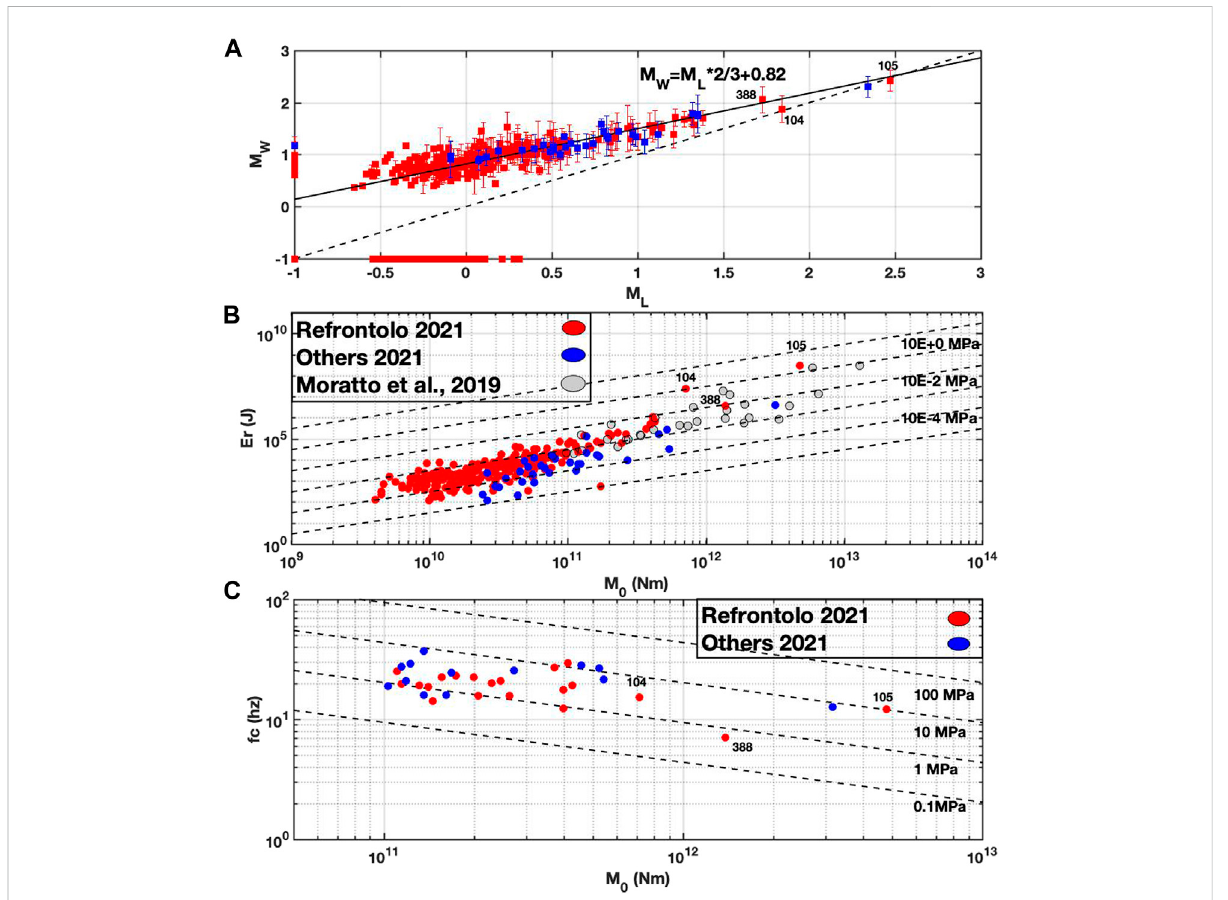
FIGURE 4 Comparison between source parameters estimated by the RSC network (HEL catalog): (A) M L vs. M W for the August 2021 events, Refrontolo sequence with red squares, the earthquakes in other areas in blue squares; the solid black line shows the empirical relationships of Lanzoni et al. (2020). Symbols along the axes (M-1) represent earthquakes without magnitude estimates (M W and M L on the x and y axes, respectively). (B) M 0 vs. radiated seismic energy (Er); symbol colors as in (A) , the gray circles represent previous events recorded by the RSC network and analyzed in Moratto et al. (2019). (C) M 0 vs. corner frequency (fc); dashed black lines represent the constant Madariaga stress drop. Event IDs of the three main earthquakes of the Refrontolo sequence as follows. 104: largest foreshock on August 3, 19:04:06, M L 1.8; M W 1.9; 105: main earthquake on August